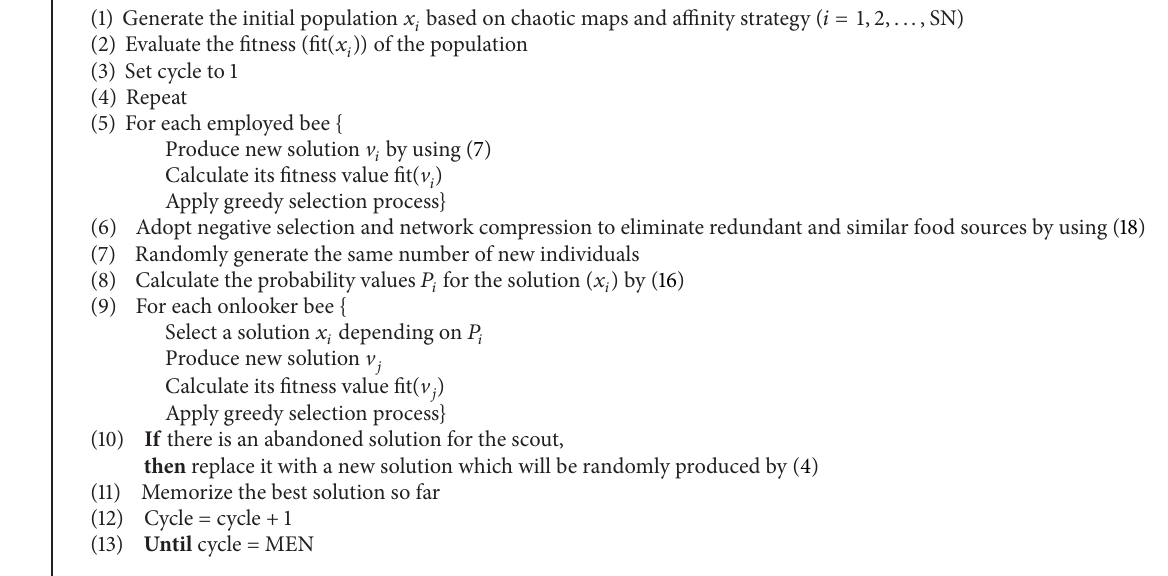
Algorithm 3: Pseudocode of main body of the enhanced ABC